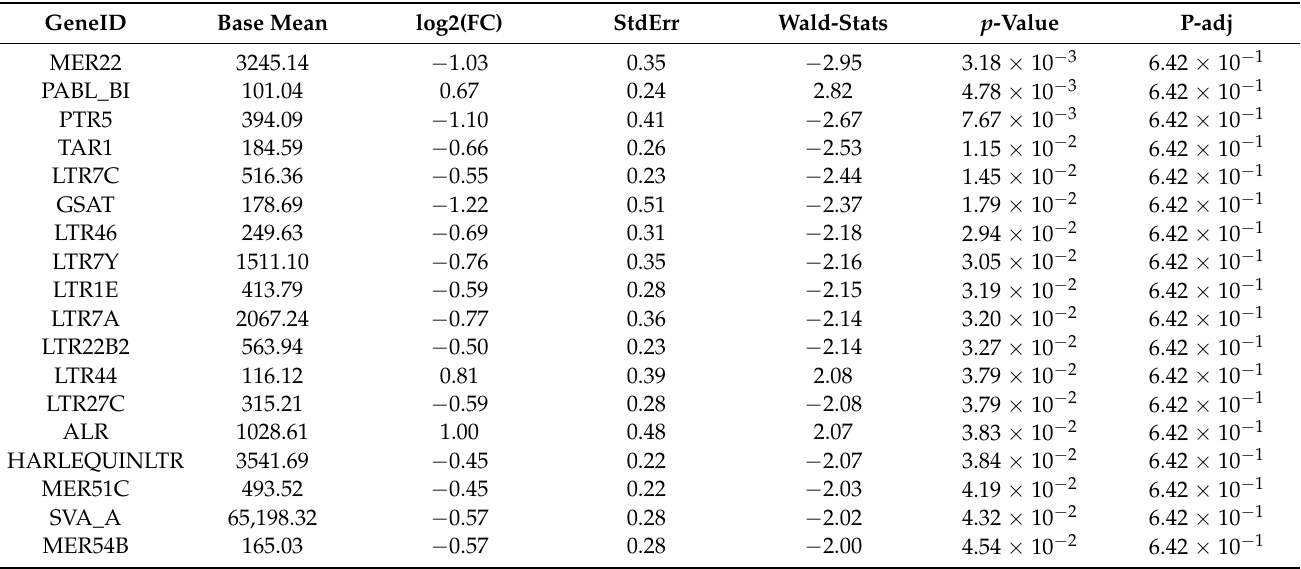
Table 2. Comparison between the expression of RS in ANT and the normal controls (ANT vs. normal). The RS whose mean expression is above 100 and with a p -value < 0.05 are